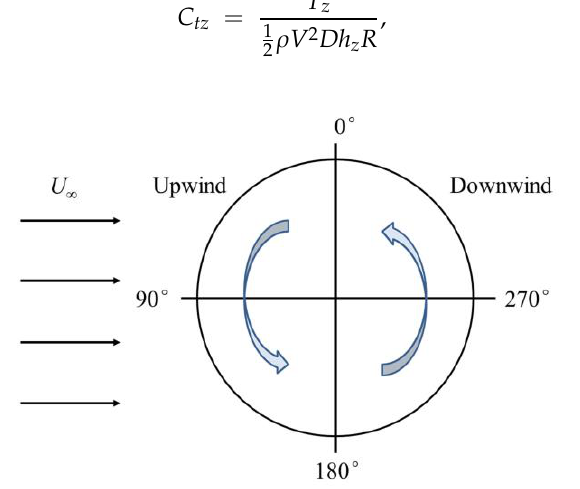
Figure 9. Upwind and downwind paths during a rotation.